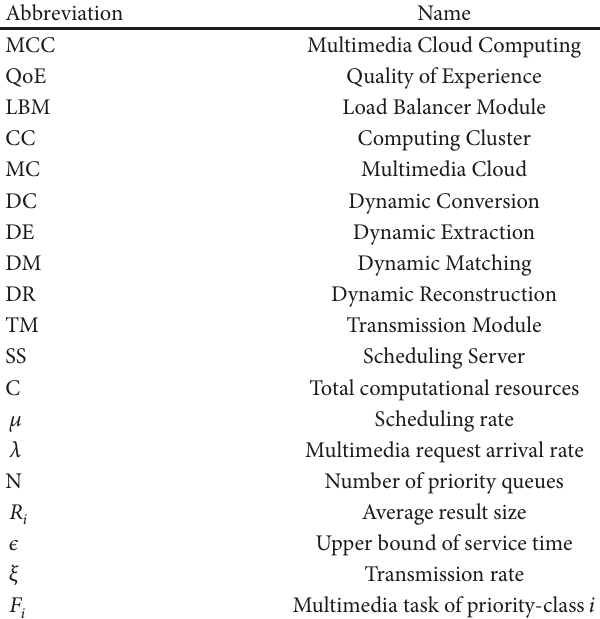
Table 1: List of acronyms and